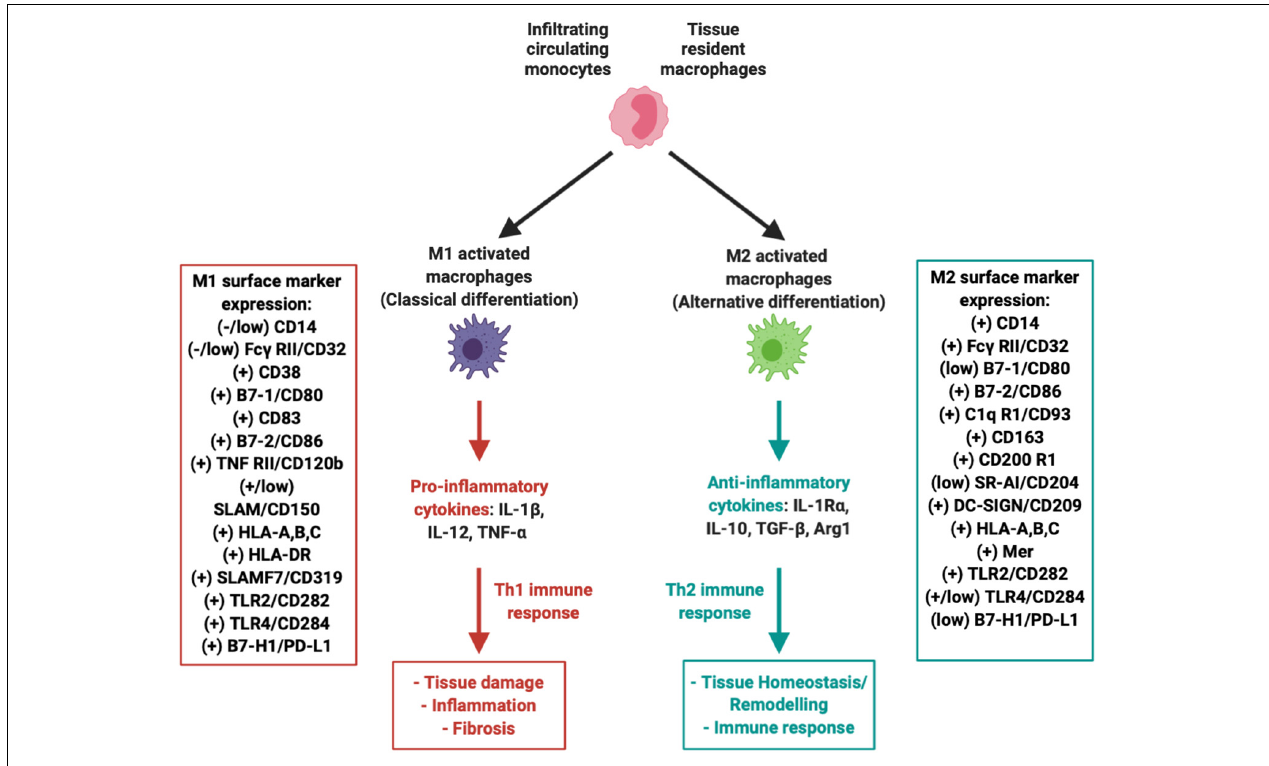
FIGURE 3 | Macrophages within the IFP can polarize into M1 (pro-inflammatory) or M2 (anti-inflammatory, tissue repair) variants. Both variants are associated with a multitude of unique surface markers with varying levels of expression that allow for proper